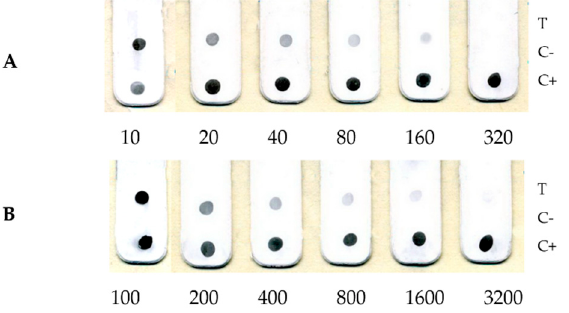
Figure 3. Comparative assay of the dilution series: ( A )-suspension from the crust from the pustule at the site of vaccination; ( B )-VACV(LIVP) preparation (initial titer 8.5 × 10 6 PFU/mL). The numbers below indicate the multiplicity of dilutions.